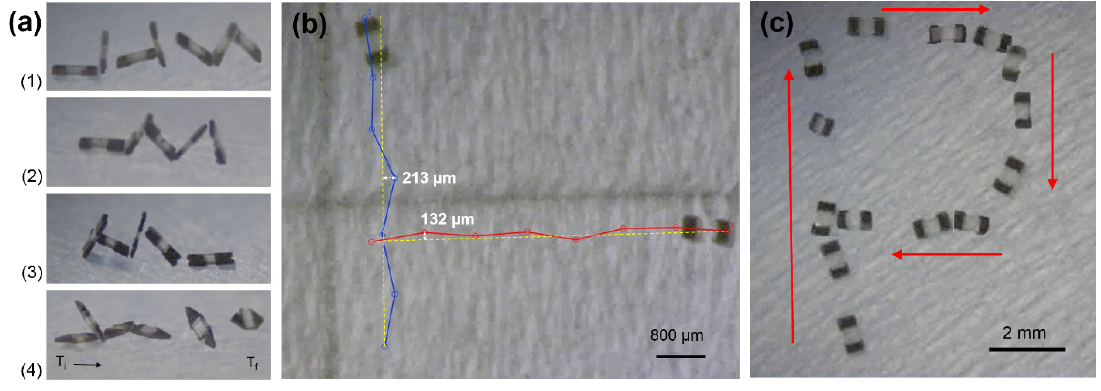
Figure 8. µ TUM locomotion tests: flat paper substrate, dry environment, with 10 mT field strength at 0.5 Hz. ( a ) Images of trials for µ TUM’s with different end variations: (1) rounded rectangle, (2) asymmetric rounded rectangle, (3) rounded corners and (4) triangle shape. ( b ) Trajectories (blue/red) of µ TUM with respect to an ideal 5 mm-long straight line trajectory (yellow); the maximum trajectory drift for each is reported. ( c ) Default rounded rectangle µ TUM design traversing the P-shaped trajectory. These results can be viewed in Supplemental Video